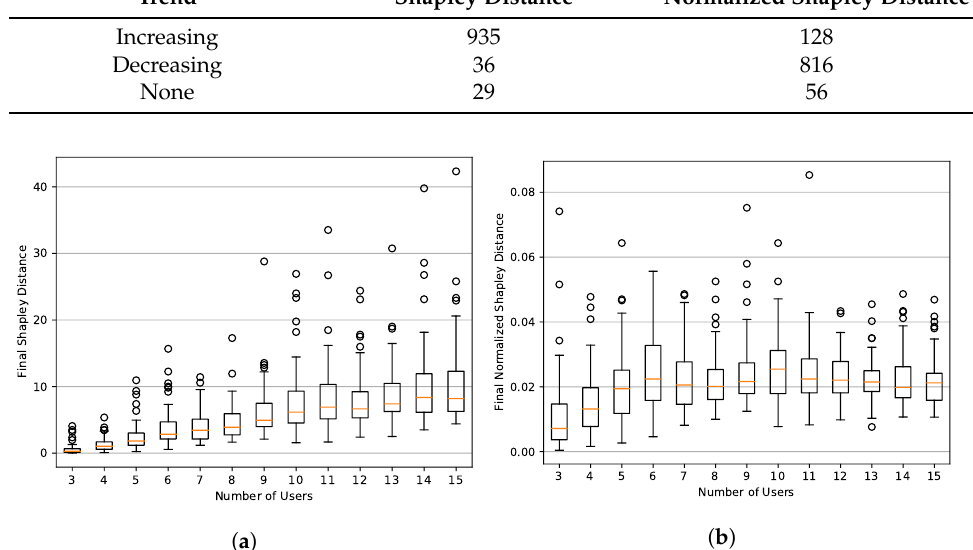
Figure 12. Boxplot of final Shapley distance ( a ) and normalized Shapley distance ( b ) with Shapley–core in 1000 trials broken down by the number of users in the community.